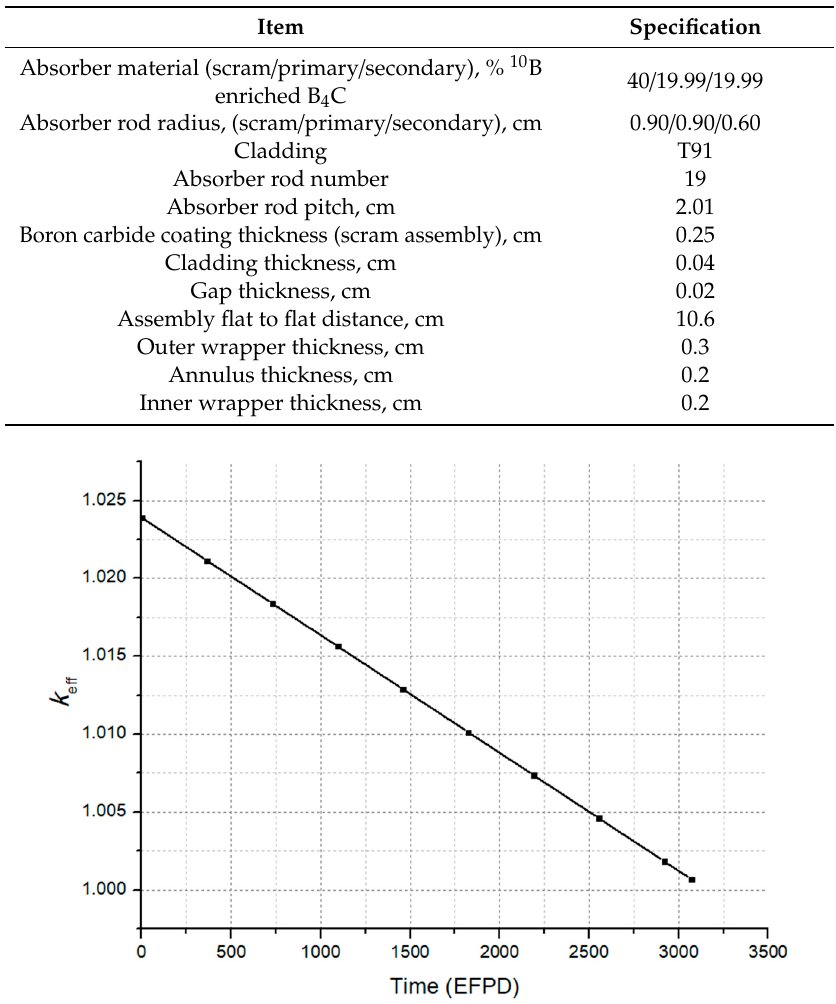
Figure 4. Scram assembly configuration. Table 3. Design parameters of the control and scram assemblies.